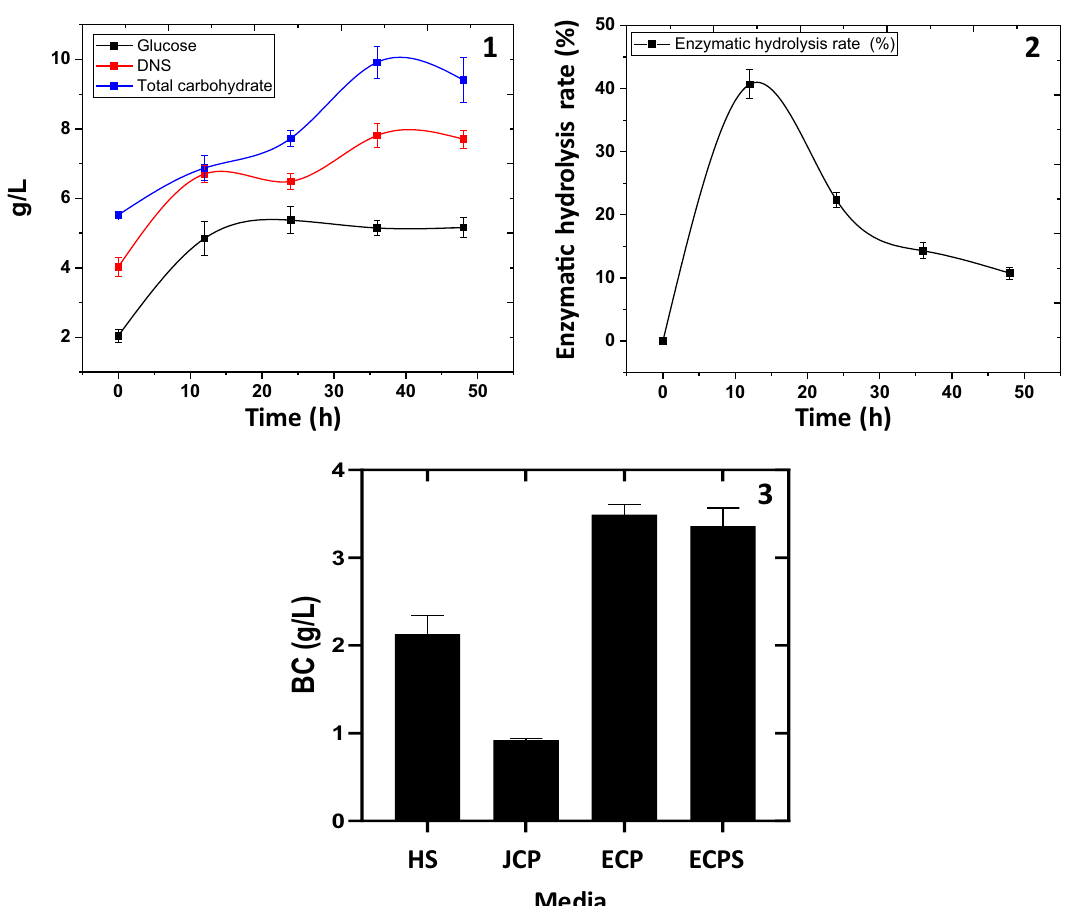
Figure 2. Scarification of CP (1), enzymatic hydrolysis rate (2) at different time intervals, and BC production from different media (3).